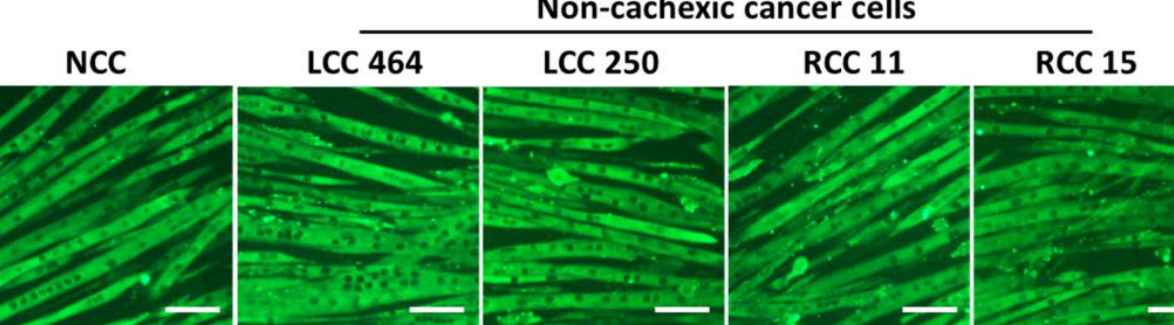
Figure 4. Conditioned medium of PCC causes myotube atrophy in an Hsp70- and Hsp90-dependent manner. C2C12 myotubes were treated as described in Figure 3 for 72 h. Myotubes were subjected to immunofluorescence staining of MHC. The myotube diameter was measured. Bar = 100 μ m. Three independent experiments ( n = 3) were carried out. Data were analyzed by one-way ANOVA followed by Bonferroni ’ s multiple comparison test. * denotes p < 0.05, ** denotes p < 0.01 and *** denotes p < 0.001. 4. Discussion The current study demonstrates that human PC cells release high levels of Hsp70 and Hsp90 to directly activate the skeletal muscle cell catabolism independently of the sys- temic host response to cancer. These data support the concept that extracellular Hsp70 and Hsp90 are biomarkers and therapeutic targets of PC-induced cachexia.